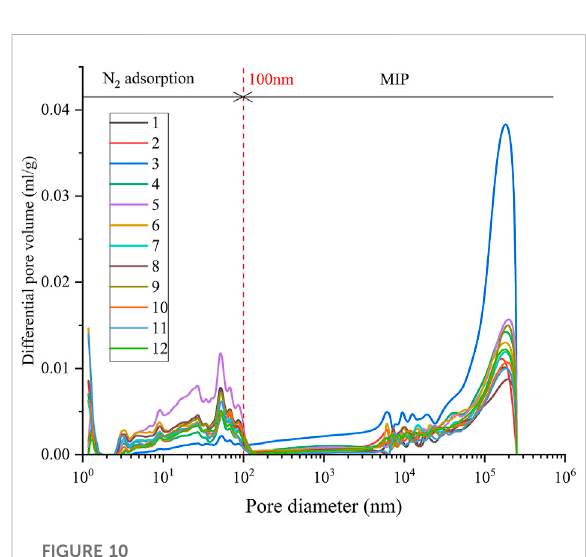
FIGURE 10 Full-scale PSDs of 12 samples gained by combining N 2 adsorption and MIP